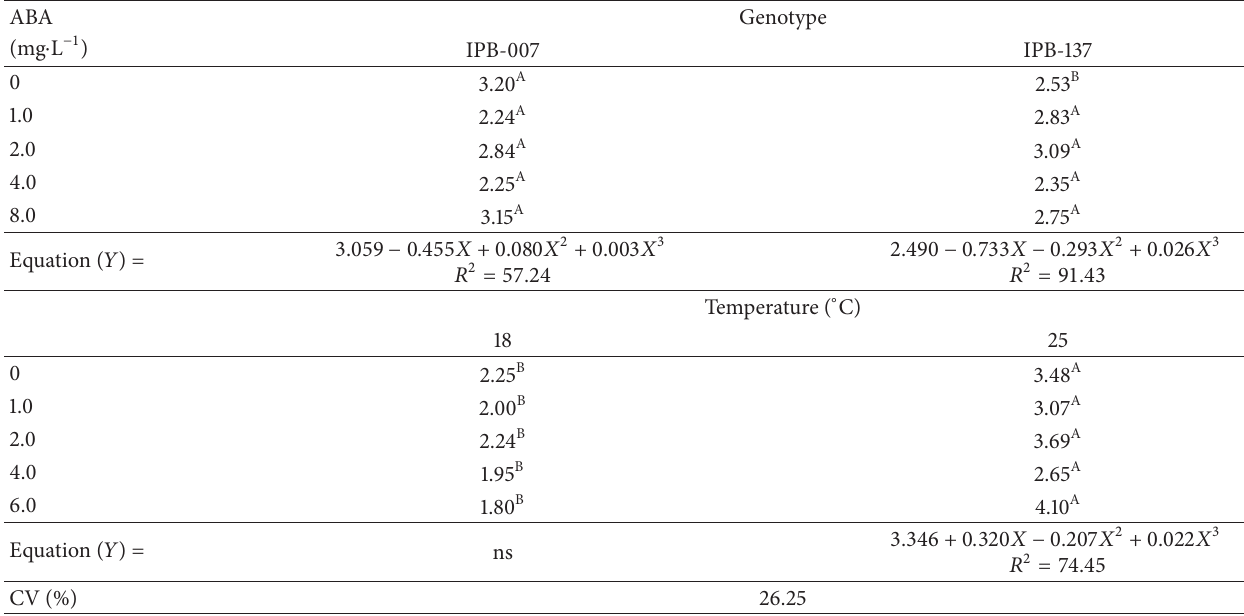
Table 3: Coloration of sweet potato plant shoots after 180 days of in vitro conservation as a function of abscisic acid concentration, temperature, and